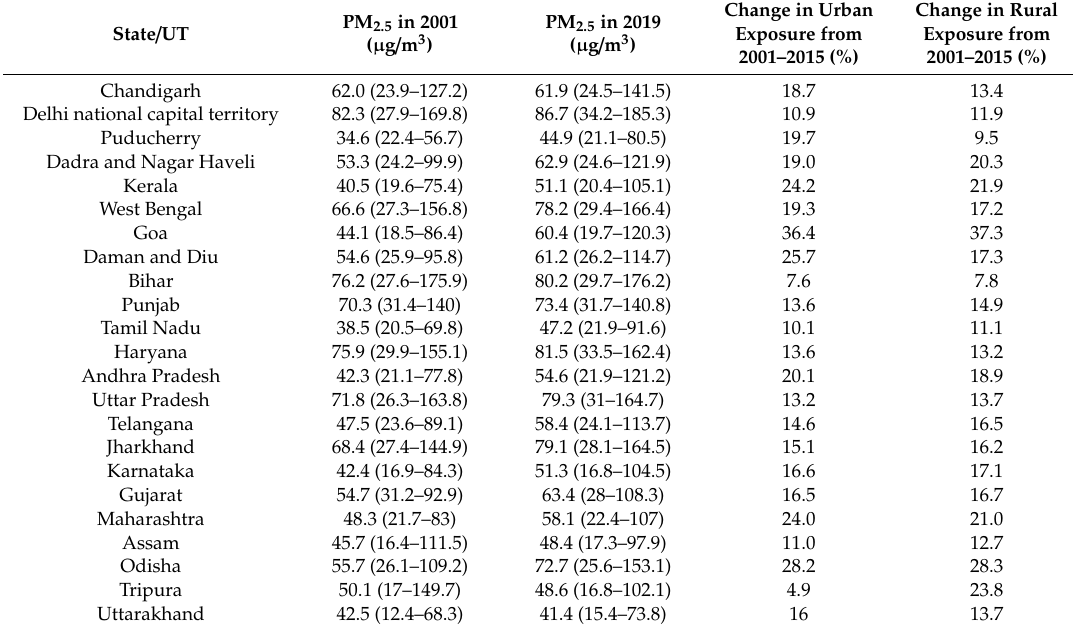
Figure A8. State-averaged fractional area (e.g., < 0.05 means < 5% area) populated by the urban and rural settlements in India in 2000 and 2015. Note that the remaining area has no permanent human settlement. Table A1. State / UT level statistics of population-weighted PM 2.5 exposure along with 5–95 percentile ranges for the years 2001 and 2019. The states / UTs are arranged in the decreasing order of urban area fraction in 2015. The urban and rural exposure changes shown here are estimated for the period 2001 to 2015, since the Global Human Settlement Layer (GHSL) data are available up to 2015. State /